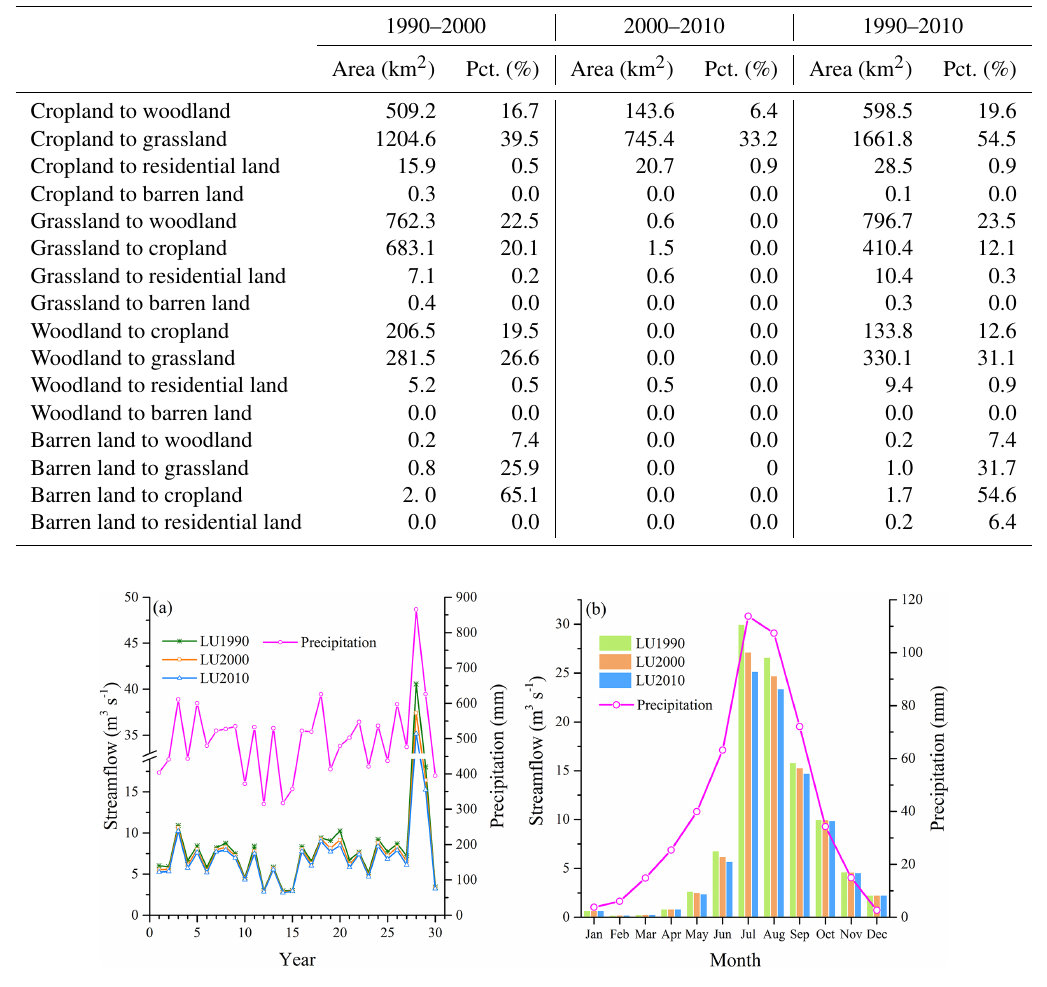
Table 3. Primary patterns of land use change in the Yanhe Basin from 1990 to 2010.